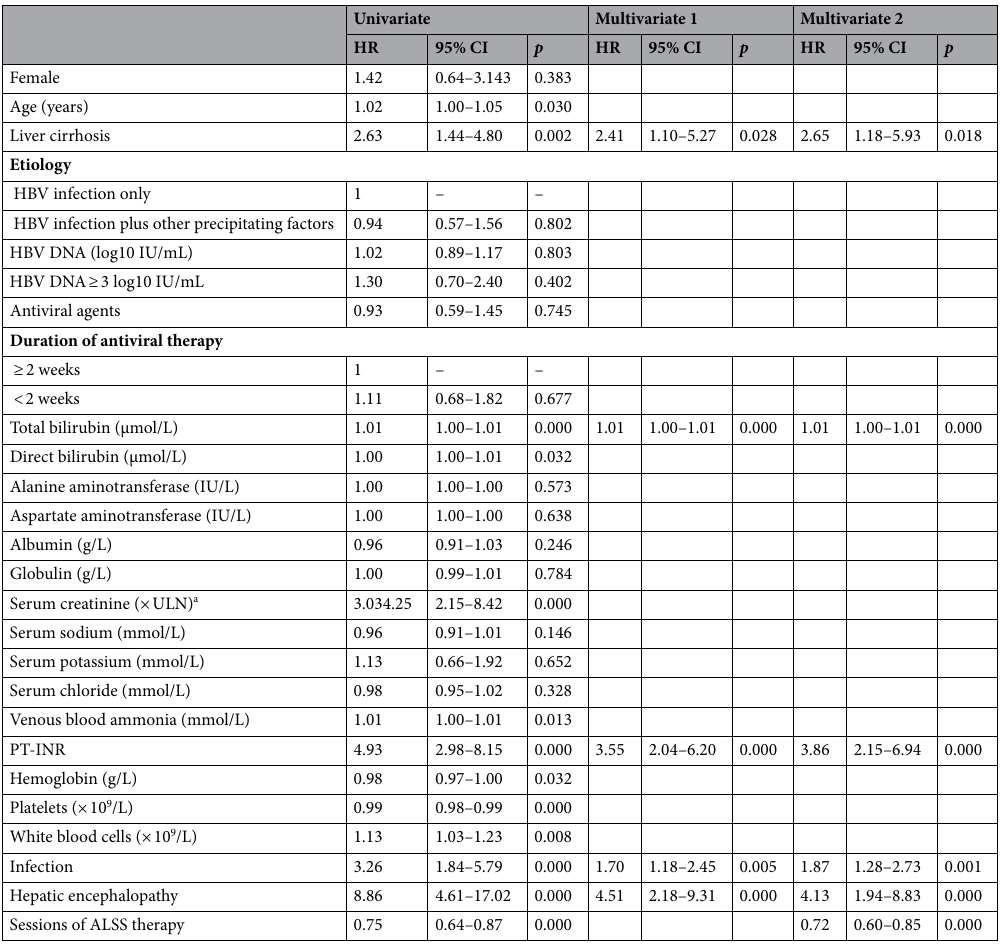
Table 2. Predictors for 3-month prognosis in derivation cohort. HR hazard ratio, CI confidence interval, HBV hepatitis B virus, PT-INR international normalized ratio (INR) of prothrombin time (PT), ULN upper limit of normal, ALSS artificial liver support system. a Serum creatinine (× ULN) equals to serum creatinine (μmol/L) divided by the upper limit of normal (Male: 106 μmol/L; Female: 88 μmol/L).